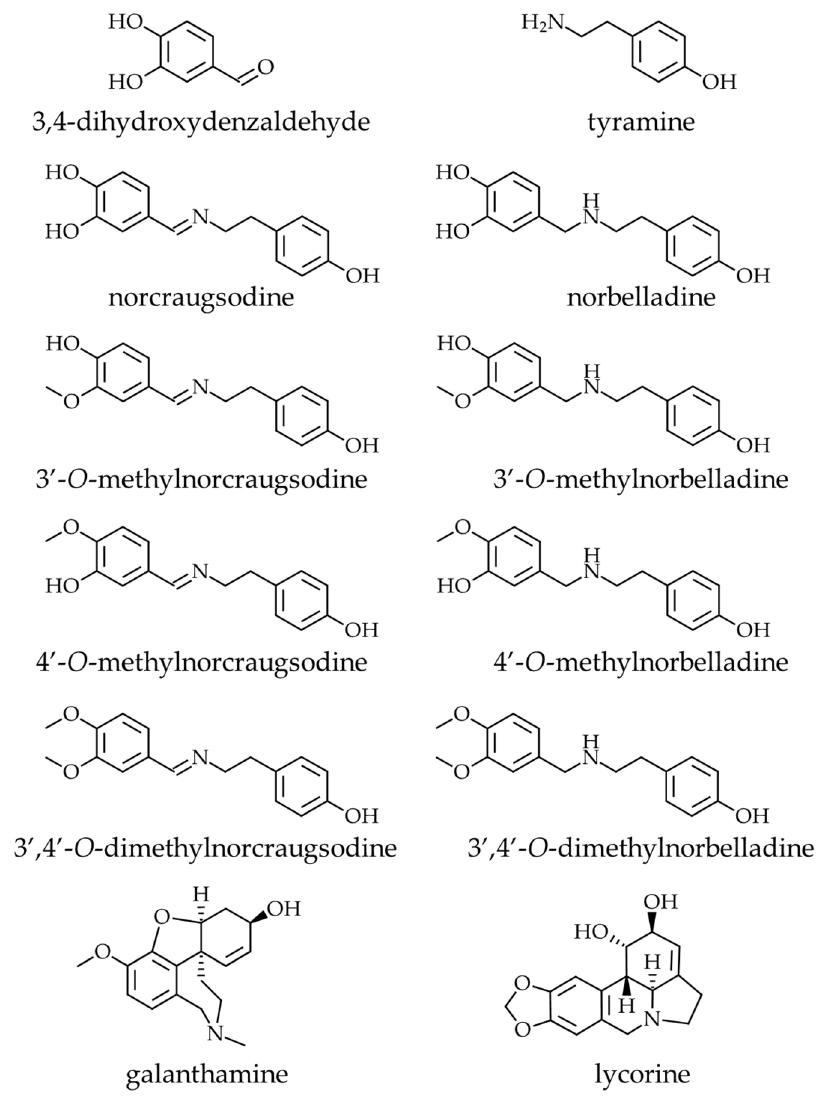
Figure 1. Chemical structures of the molecules used in this study. Amaryllidaceae alkaloid precursors (3,4-dihydroxybenzaldehyde and tyramine), intermediates (norcraugsodine and norbelladine), their corresponding O -methylated derivatives (3 (cid:48) - O -methylnorcraugsodine, 3 (cid:48) - O -methylnorbelladine, 4 (cid:48) - O -methylnorcraugsodine, 4 (cid:48) - O -methylnorbelladine, 3 (cid:48) ,4-’ O -dimethylnorcraugsodine, and 3 (cid:48) ,4 (cid:48) - O - dimethylnorbelladine), and the well-known AAs galanthamine and